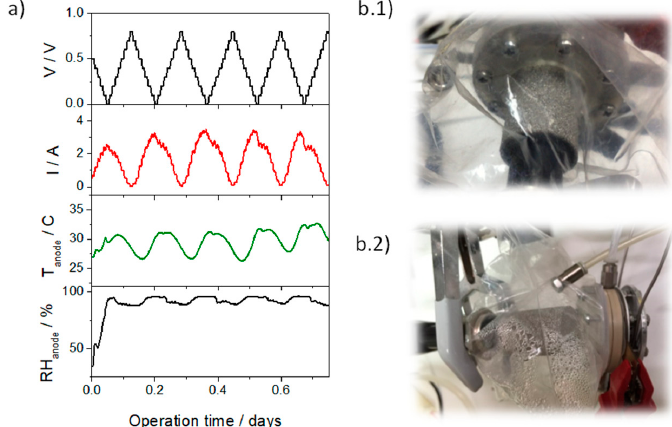
Figure 7. ( a ) Operation parameters of the novel air-breathing PEM fuel cell assembled to analyze the humidity released from the dead-end anode chamber: cell voltage, cell current, temperature measured at the sensor in the bag, relative humidity registered by the sensor near the water selectively permeable side of the anode chamber with a sweep nitrogen flow rate in the hermetically closed bag of 0.03 mL · s − 1 . ( b ) Image of the assembly for relative humidity and temperature measurements at the external anode side: ( b1 ) before operation, ( b2 ) after 4 hours under continuous operation using a sweep gas flow of 0.03 mL · s − 1 inside the bag.